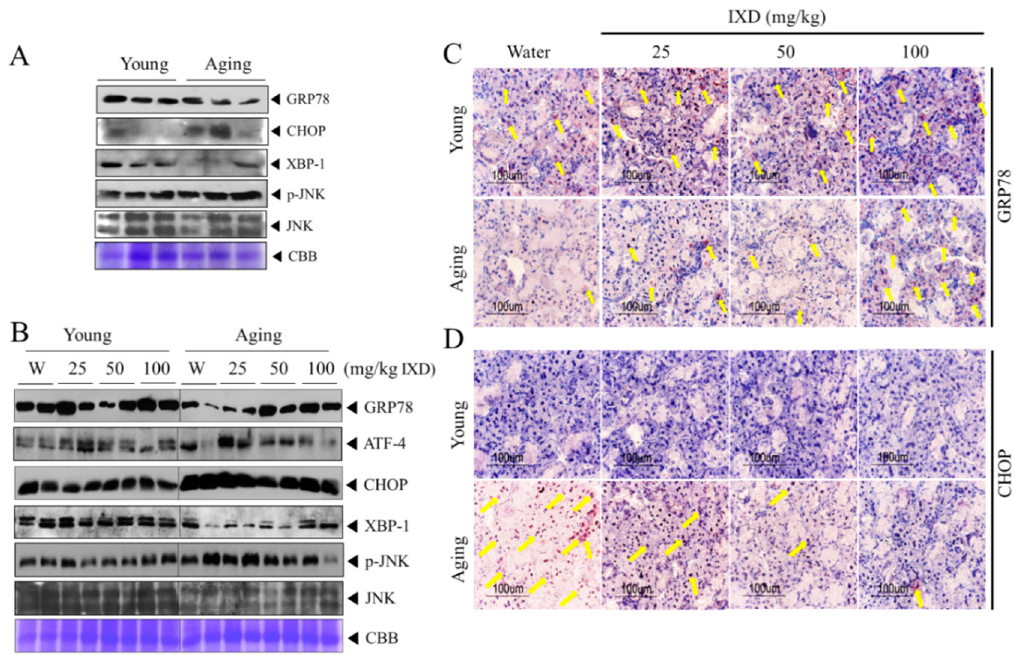
Figure 8. IXD extract regulates aging-induced unfolded protein response (UPR) impairment in the submandibular gland. ( A ) Western blotting was performed to demonstrate the UPR in young and aging submandibular glands. Protein expressions of the endoplasmic reticulum (ER) stress markers GRP78, CHOP, XBP1, and p-JNK was determined. CBB staining was done to show the equal loading pattern as a control. ( B ) The protein expression of different UPR components (GRP78, ATF-4, CHOP, sXBP1, p-JNK, and JNK) was analyzed in the submandibular glands of young and aging rats treated with water or IXD extract. ( C , D ) Immunolocalization of GRP78 and CHOP in the submandibular glands of the indicated groups. Magnification: 400×, Scale bar: 100 µm. UPR, Unfolded protein response; CBB, Coomassie brilliant blue. Yellow arrows indicate the positive expression of GRP78 and CHOP.